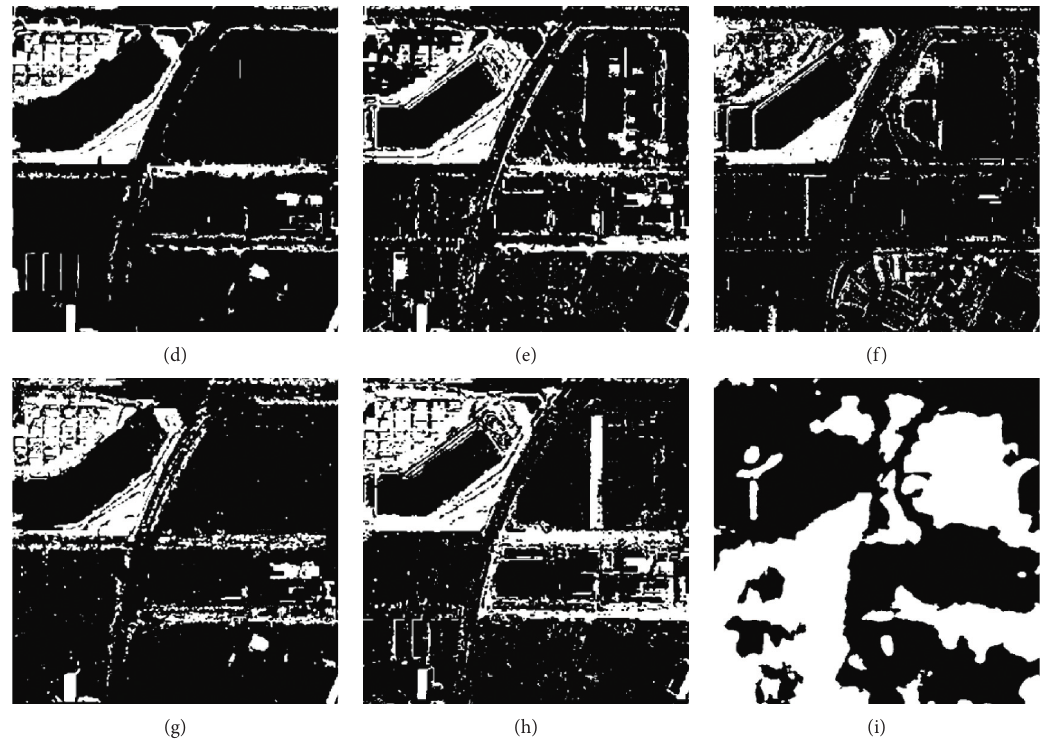
Figure 4: CD maps of dataset 2: (a-b) dataset 2; (c) reference map of dataset 2; (d–i) CD maps obtained in dataset 2 using the proposed method and Methods 1, 2, 3, 4, and 5,